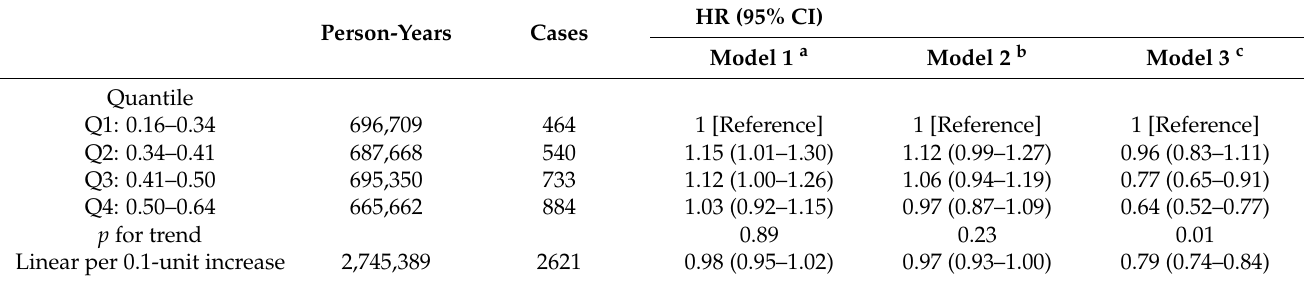
Table 3. Association between exposure to normalized difference vegetation index and incidence of Parkinson’s disease in 1-year time-varying Cox hazards